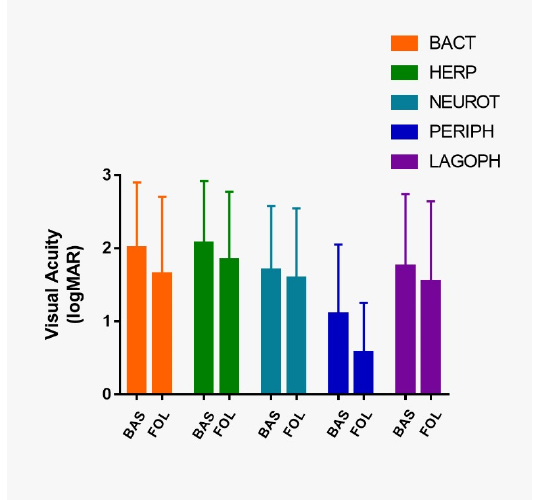
Figure 4. Bar chart representing visual acuity (VA) in logMAR at baseline and at the last follow-up. VA, visual acuity; BACT, post-bacterial ulcers; HERP, post-herpetic ulcers; NEUROT, neurotrophic ulcers; PERIPH, non-rheumatic peripheral ulcers; LAGOPH, ulcers secondary to lagophthalmos and eyelid malposition or trauma; BAS, at baseline; FOL, at the last follow-up.